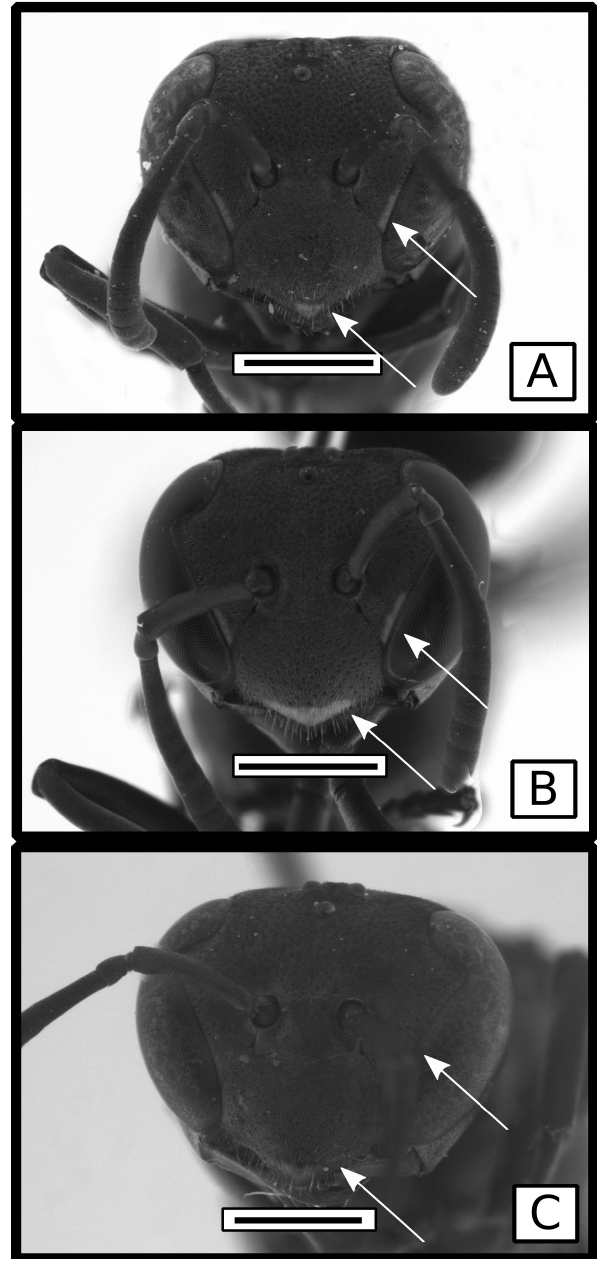
Fig 3 . Metapolybia fraudator – Head frontal view: A = Peru, Tingo Maria (Nest G); B = Brazil, Novo Airão, ME2; C = Brazil, Novo Airão, ME1. Scale bar = 1.0 mm.